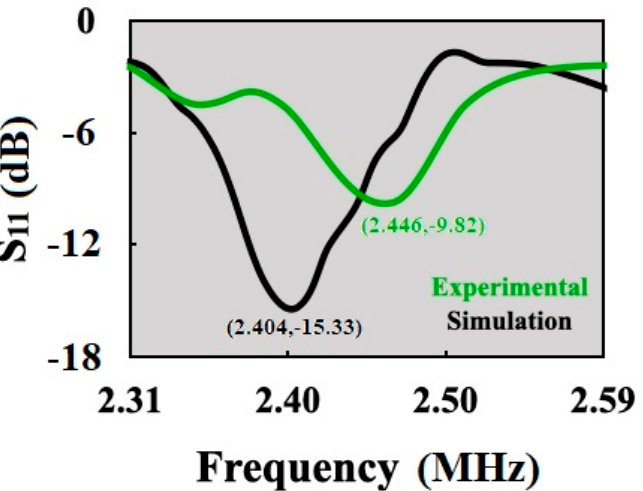
Figure 4. S 11 comparison between simulation (black) and experimentally measured (green) for 3 N pac .